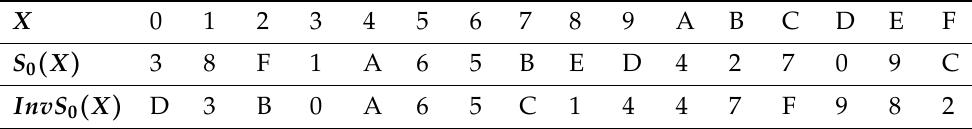
Table 1. First S-Box of Serpent defined as S 0 ( X ) .